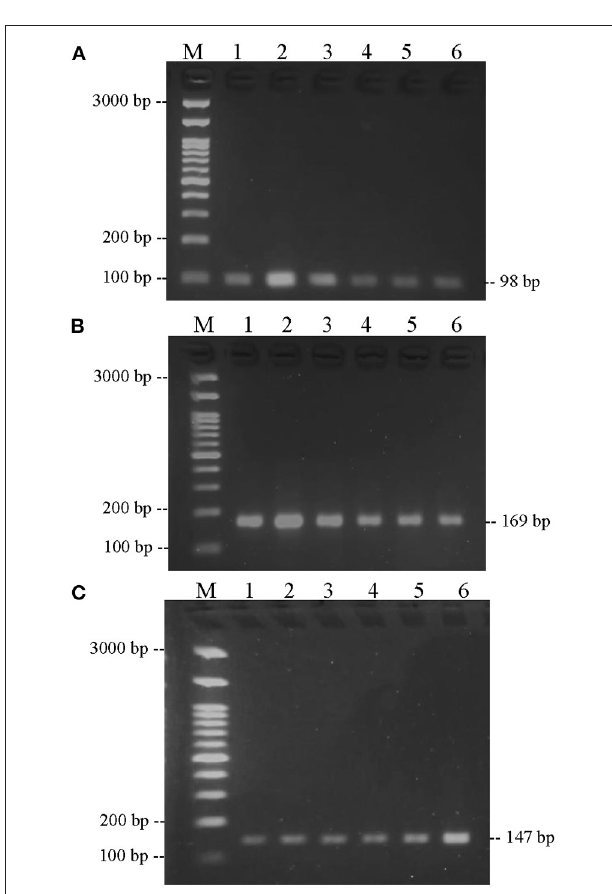
FIGURE 4 | Results of primer specificity test. (A) Bovine primer; (B) chicken primer; (C) pork primer in various species, electrophoresed on 2% agarose gel. (1) Indonesia native chicken; (2) broiler chicken; (3) layer chicken; (4) Boss taurus cattle; (5) Bos indicus cattle; (6) pork; (7) quail; (8) Manila duck; (9) duck; (10) sheep; (11) goat; (12) red tilapia; (13)